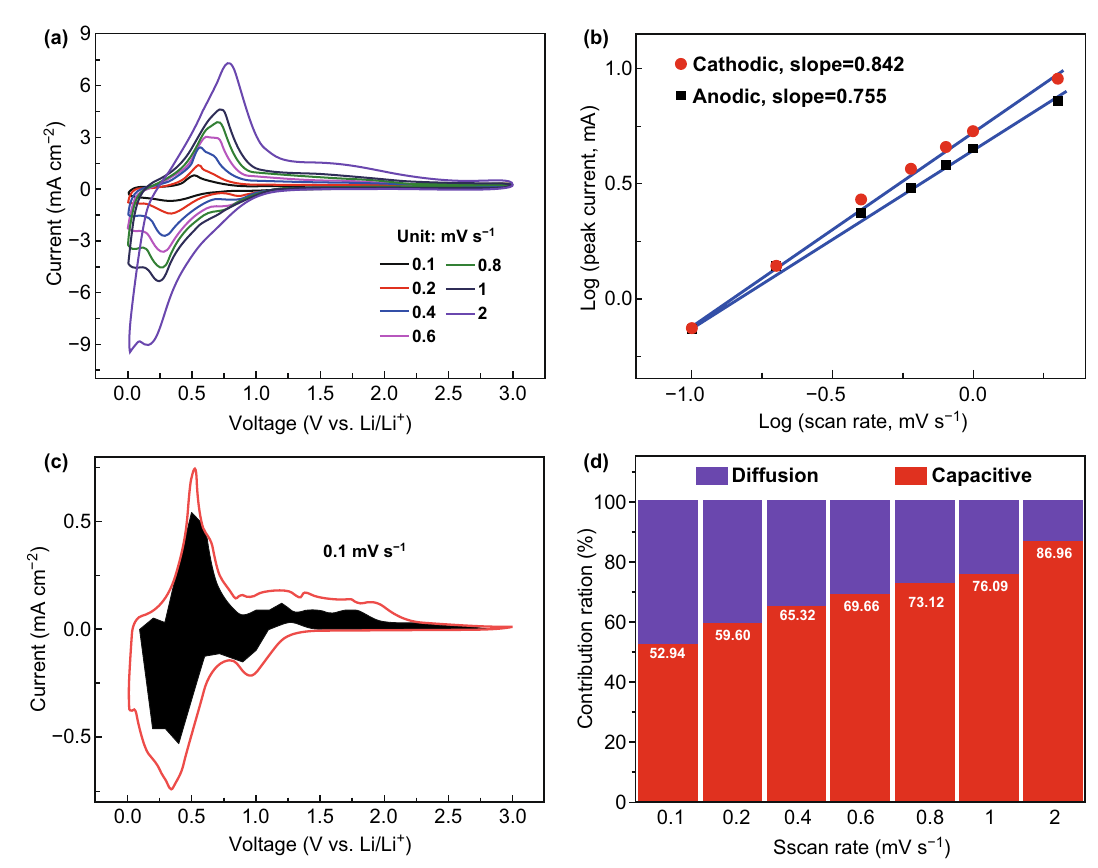
Fig. 6 a CV curves of STCT electrodes at different scan rates from 0.1 to 2 mV s −1 . b Plots for log ( i ) versus log ( v ), where i is the peak current and v is the scan rate. c Capacitive contribution proportion compared with the total current response at 0.1 mA s −1 . d Bar charts of the capacitive contribution proportion at different scan rates (from 0.1 to 2 mV s −1